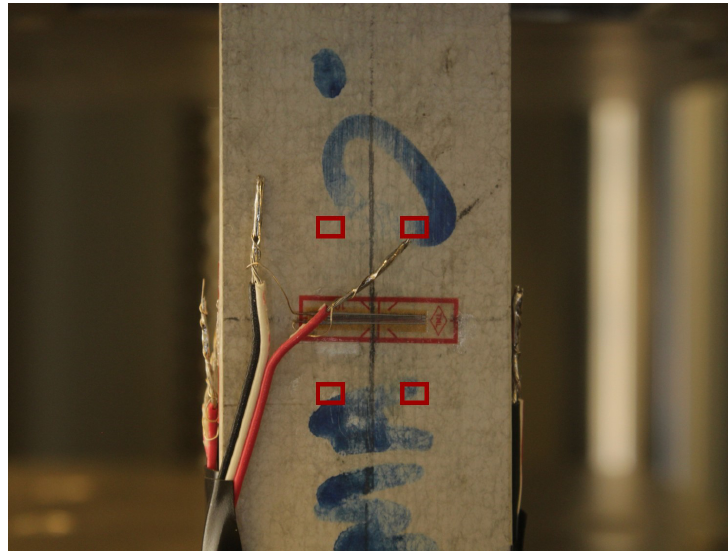
Figure 14. Strain gauge